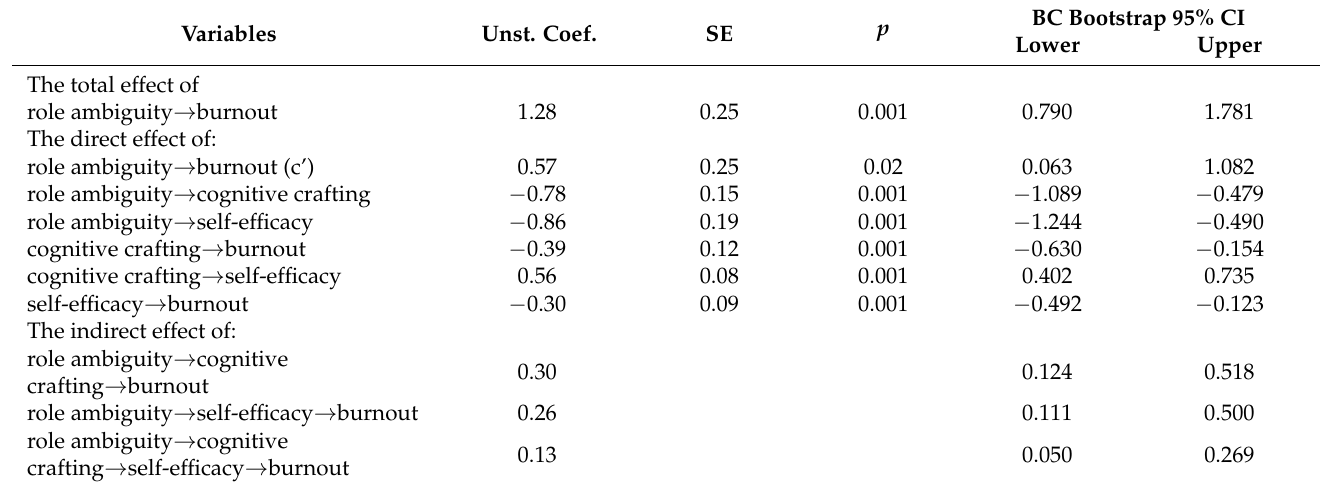
Table 3. Total, direct, and indirect effects of the sequential mediation model 1—role ambiguity on burnout through cognitive crafting and resilience (PROCESS).